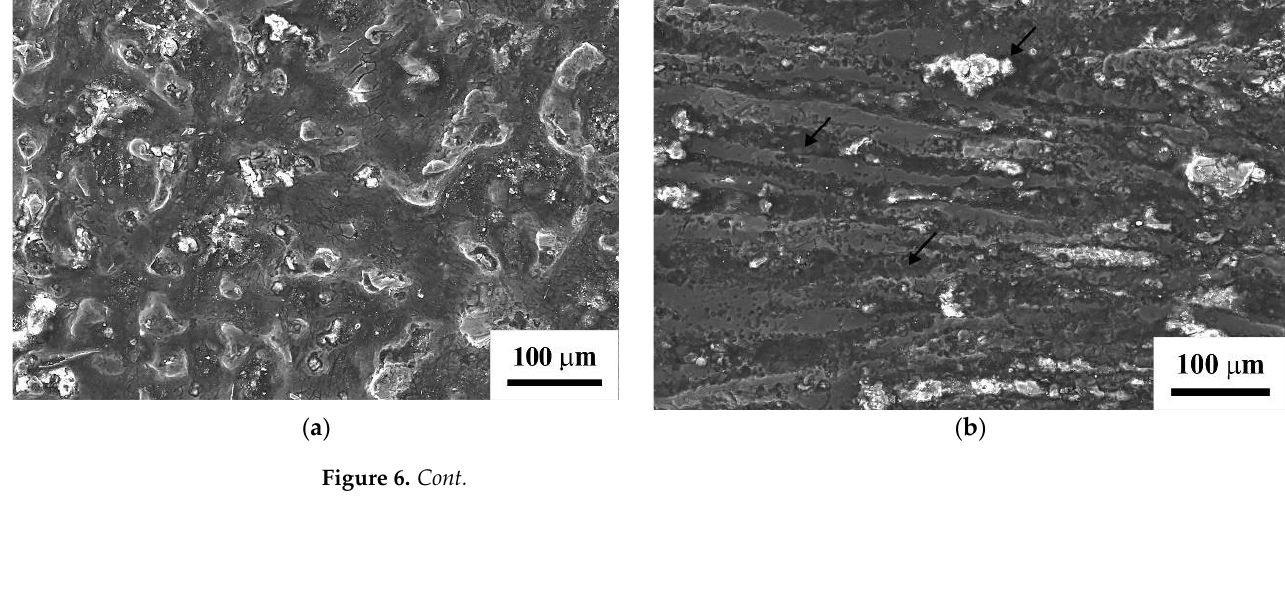
Figure 5. The photograph of the longitudinal section of the specimen and corresponding microhard- ness map of the Mg-Al-Zn alloy after reduction–ECAP and UST ( a ). The values of microhardness averaged over each plane of cross-section on the coordinate x along the sample length ( b ).